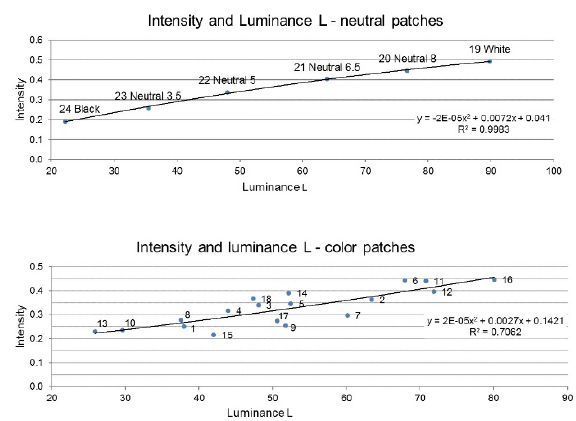
Figure 6. Relationship between intensity and CIE chromatic coordinates LCH: a) neutral patches b);